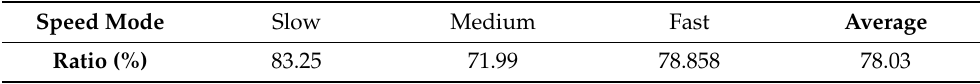
Table 4. Average decrease ratio of RMSE coefficient (%).